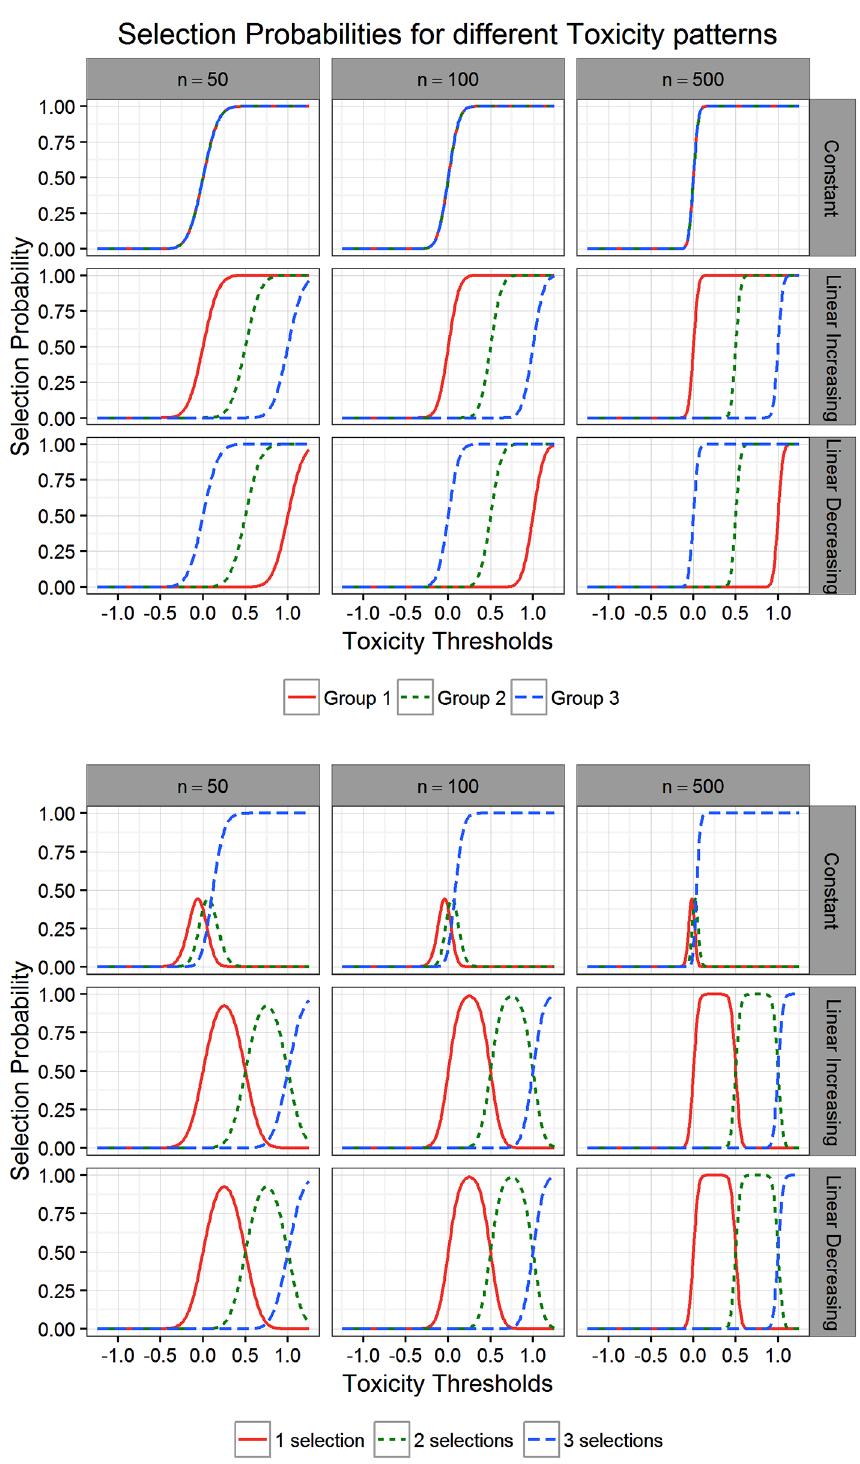
Fig 6. Selection probabilities for different toxicity patterns. In the upper plot the probabilities of selecting treatments 1, 2 or 3 are drawn. The probabilities of selectingexactly 1, 2, or 3 treatments are drawn in the lower